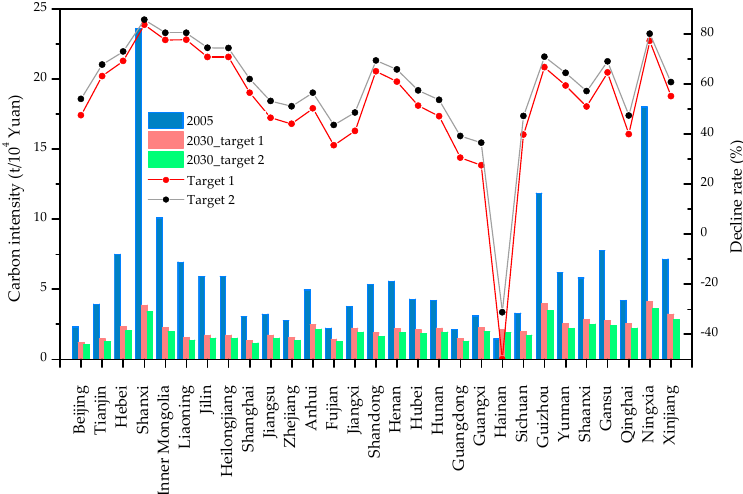
Figure 6. Carbon intensity and decline rates of 29 provinces in China. Table 14. Provincial classification by carbon intensity.